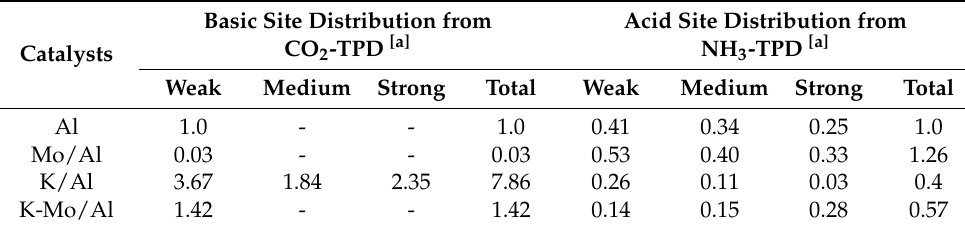
Figure 6. TPD spectra of the catalysts, ( a ) CO 2 -TPD, ( b ) NH 3 -TPD. Table 1. The quantity distribution of acid-basic sites on the surface of the catalysts. Basic Site Distribution Catalysts